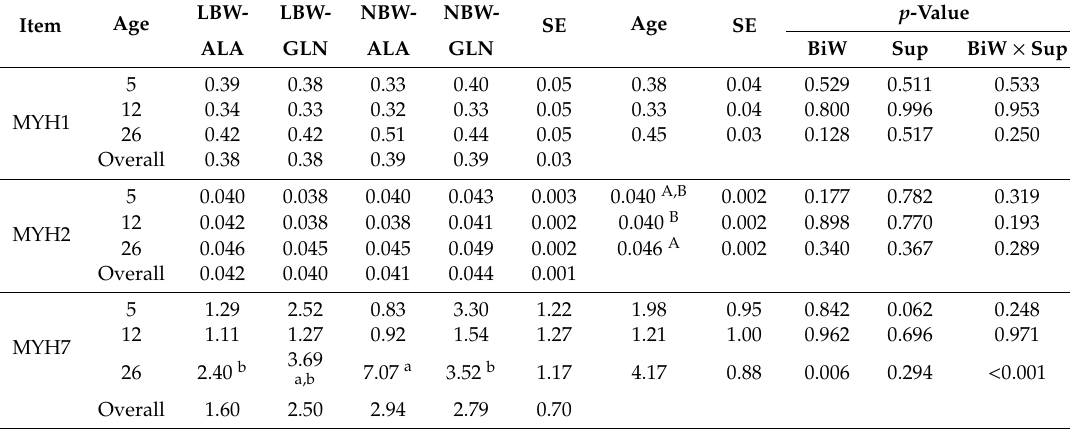
Table 5. Relative normalized protein abundance of MYH isoforms in M. semitendinosus of low (LBW) and normal birth weight (NBW) piglets supplemented with glutamine (GLN) or alanine (ALA) between 1 and 12 dpn ( n = 12 for MYH7 and n = 6 for MYH1 and 2 per group and